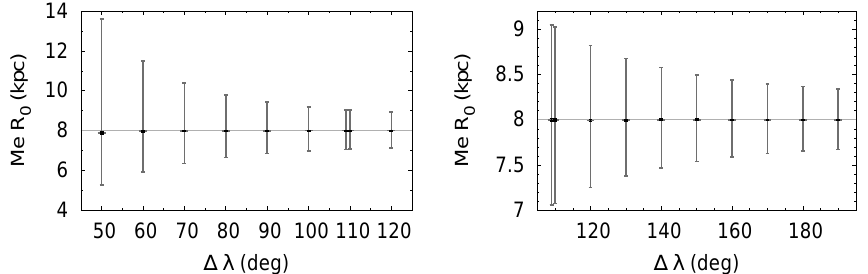
Fig. 6. Median and standard deviation of R 0 estimate (the gray dashes and error bars) and the uncertainty of Me R 0 (the black error bars) vs. ∆ λ in the case of constant λ s 1 (left panel) and λ s 2 (right panel).